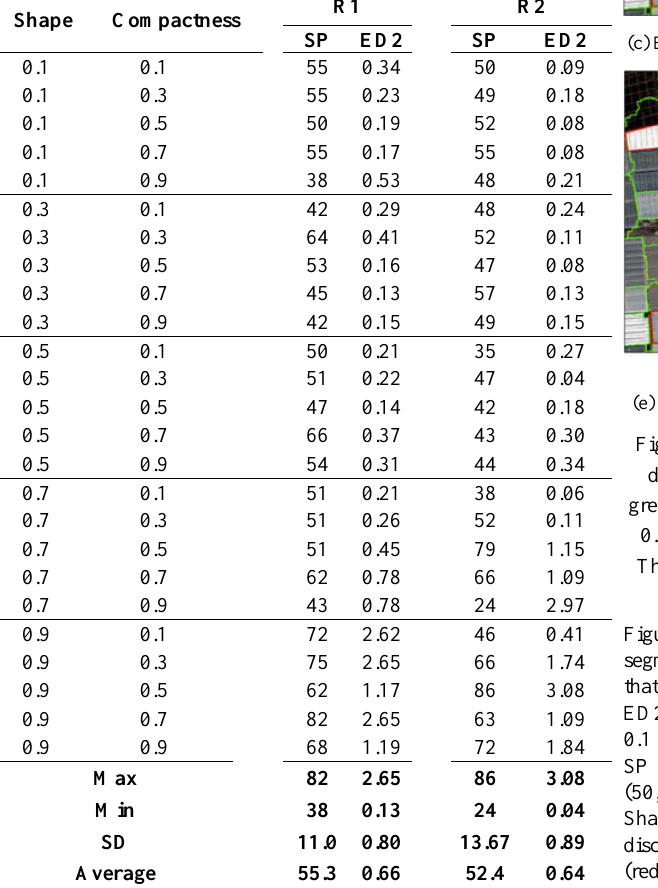
Table 2. Values and statistics for Euclidean Distance 2 (ED2) according to each combination of Shape, Compactness and scale parameter (SP computed with ESP2 tool) for both R1 and